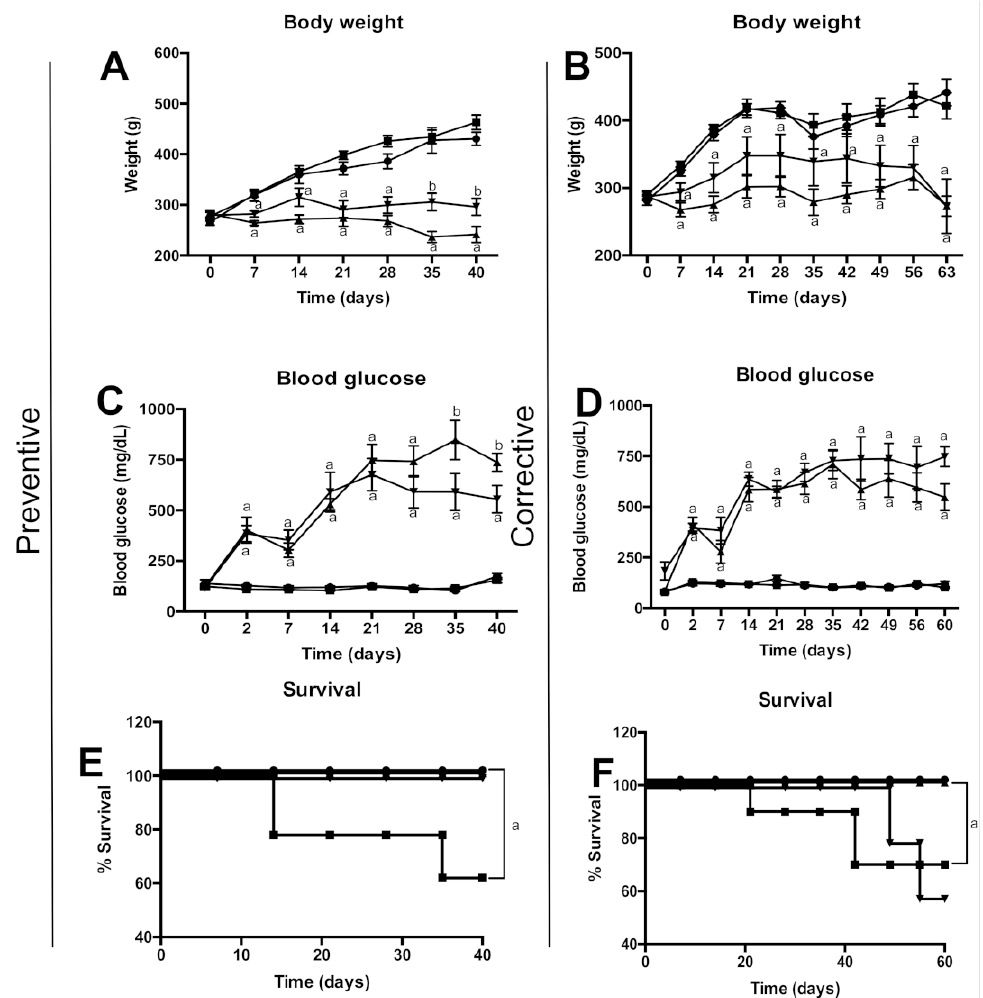
Figure 1. Metabolic parameters in preventive scheme and corrective scheme. ( A ) Weekly body weight monitoring in the preventive scheme; ( B ) Weekly body weight monitoring in the corrective scheme. ( C ) Weekly blood glucose monitoring in the preventive scheme; ( D ) Weekly blood glucose monitoring in the corrective scheme; ( E ) Overall survival throughout preventive scheme; ( F ) Overall survival throughout corrective scheme. ( ) Control, ( (cid:4) ) Pinocembrin, ( (cid:78) ) Diabetic, ( (cid:72) ) Diabetic + Pinocembrin, a p < 0.05 vs. Control, b p < 0.05 vs. Diabetic, n =